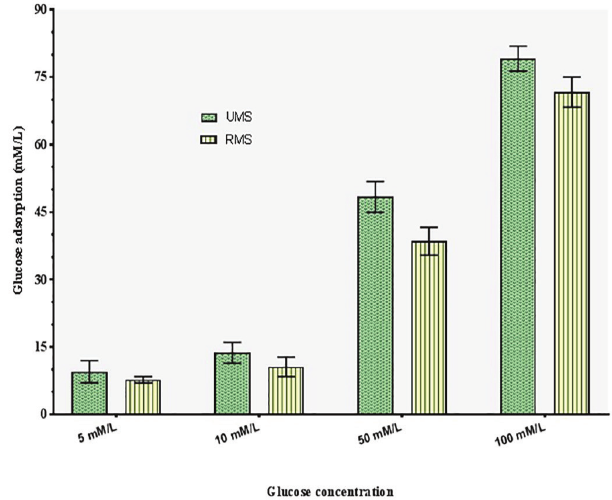
FIGURE 1 - Glucose binding capacity of extract of unripe and ripe fruit of Musa sapientum at different concentrations of glucose. (Values are mean + SD of triplicate